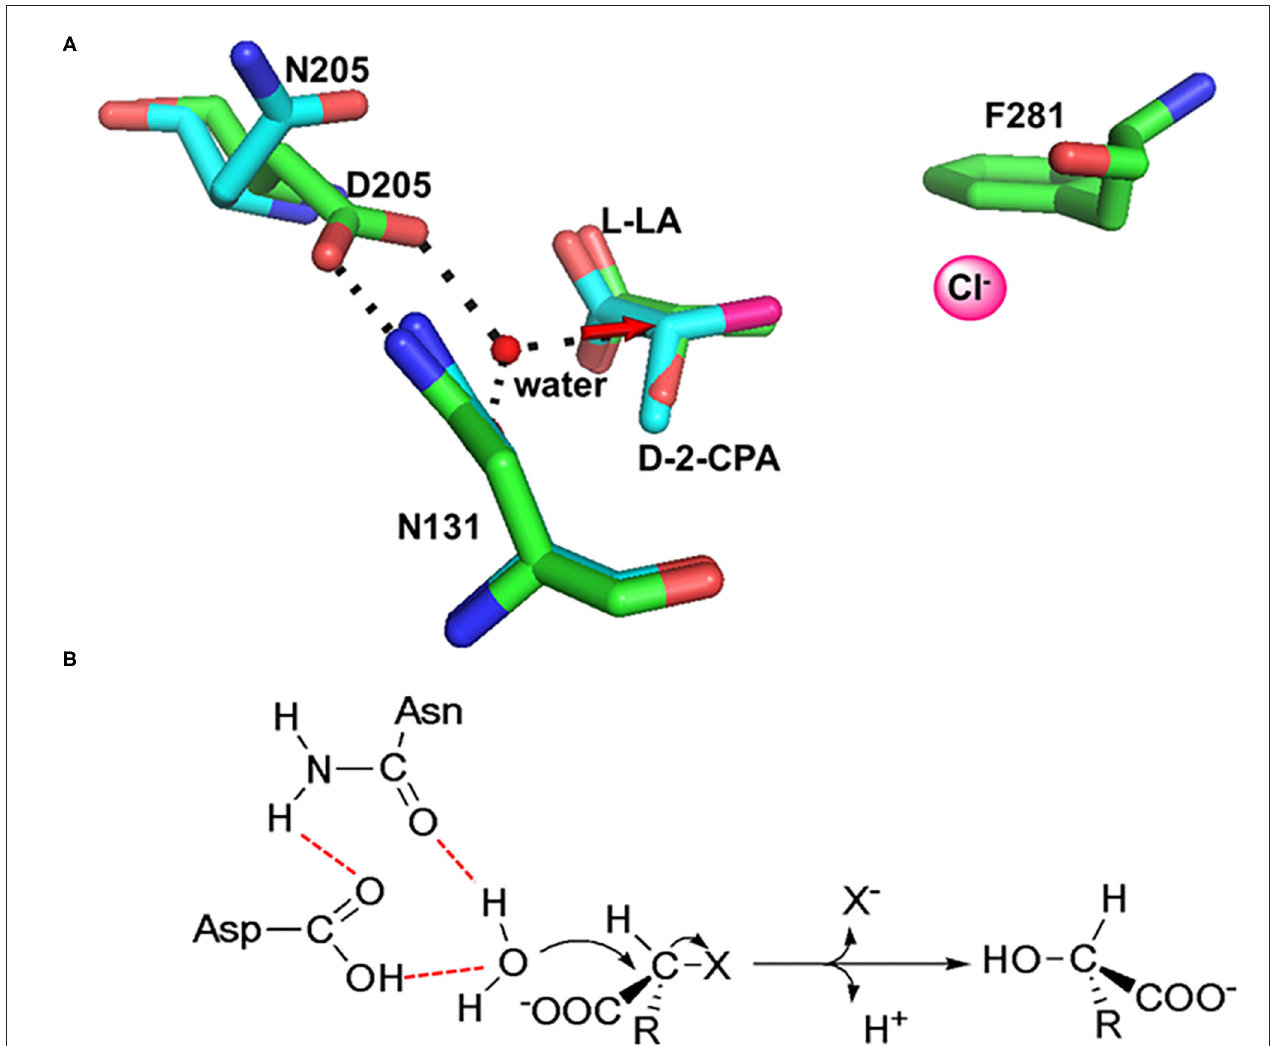
FIGURE 7 | The molecular mechanism of dehalogenation catalyzed by D-DEX. (A) Structural superimposition of WT/L-LA (green, PDB ID: 5gzy) and D205N/D-2-CPA (cyan, PDB ID: 5gzx) complex. (B) Reaction mechanism of D-DEX ( Wang et al.,